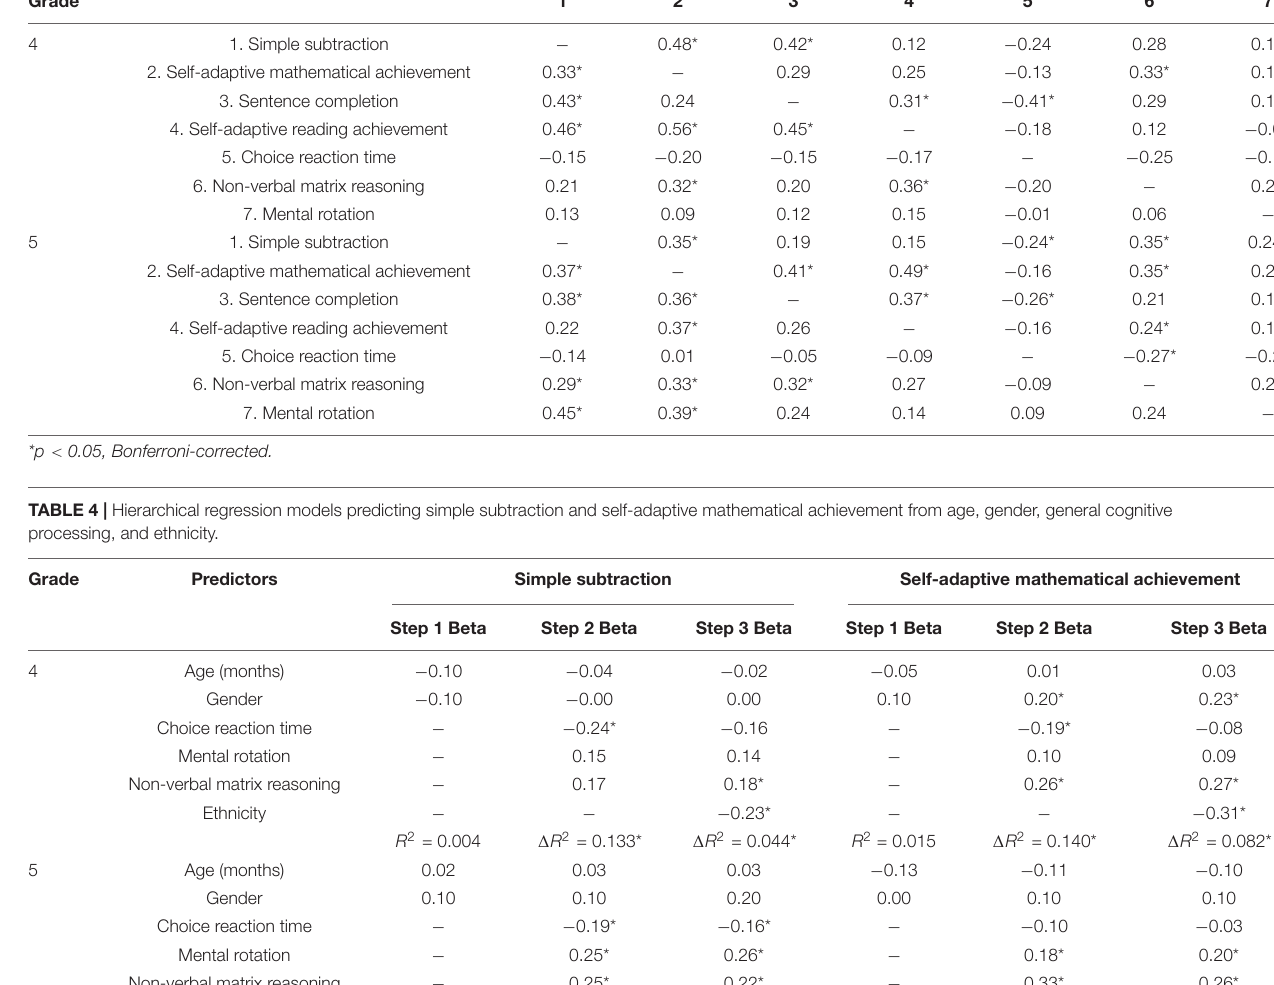
TABLE 3 | Partial correlations between the measures used in the study for Minority (above the diagonal) and Han (below the diagonal) (controlling for age and gender). Grade